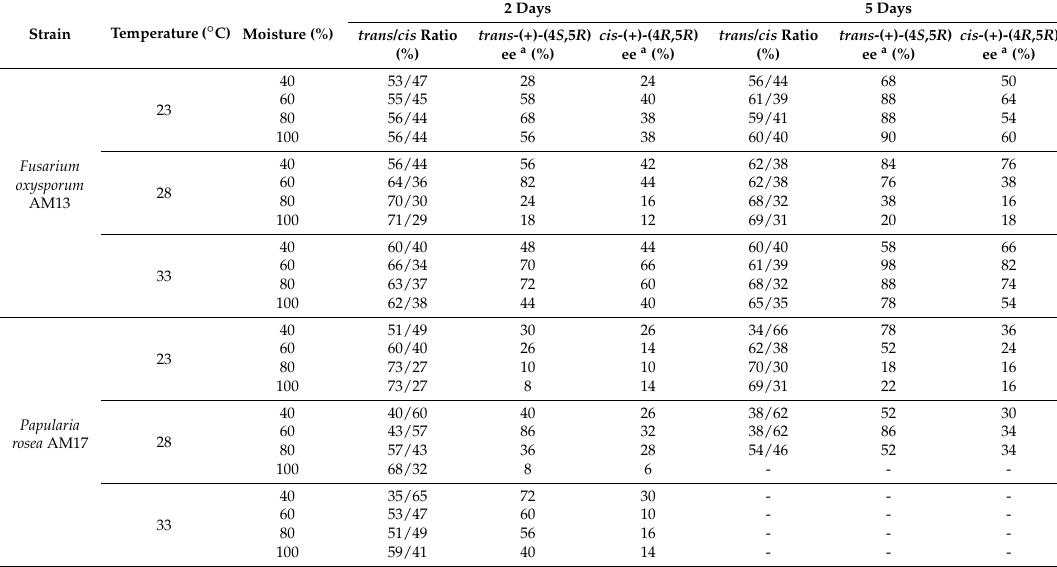
Table 2. Effect of temperature and moisture content on biotransformation of diastereoisomeric mixture of whisky lactone (in % according to